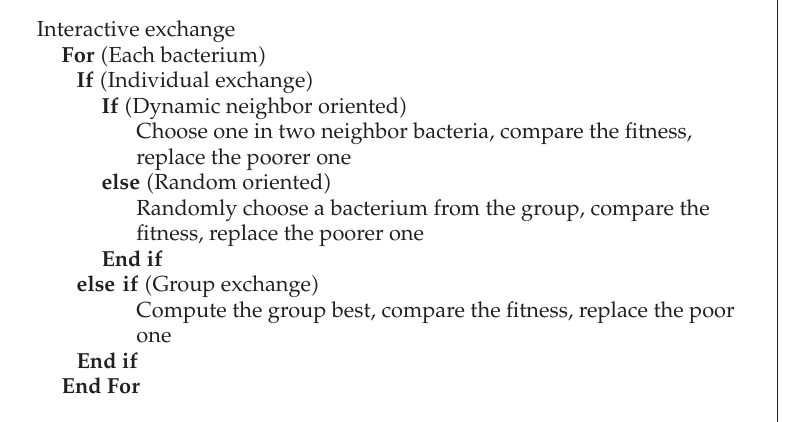
Pseudocode 3: Pseudocode of interactive